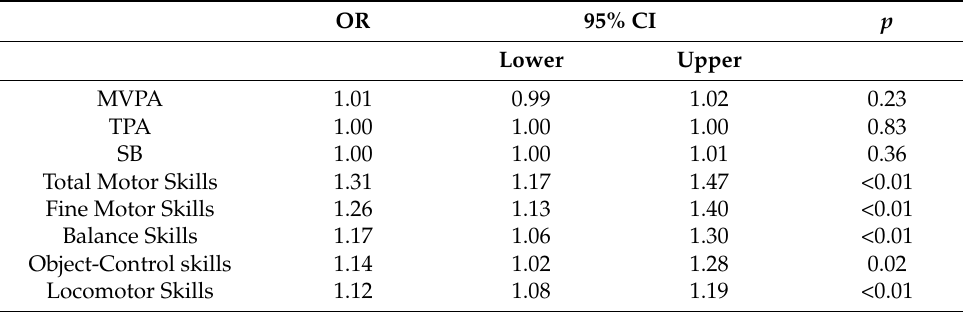
Table 5. Logistic regression predicting achievement of a good level of development.